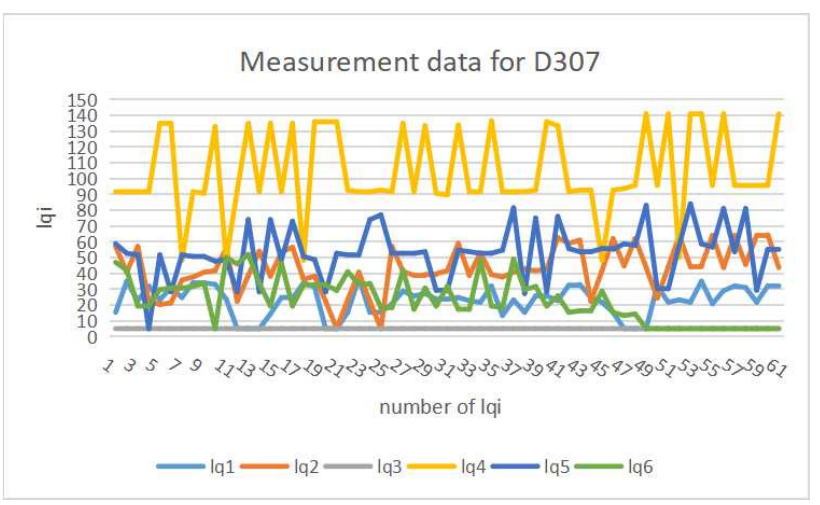
Figure 1. Experiment field layout.